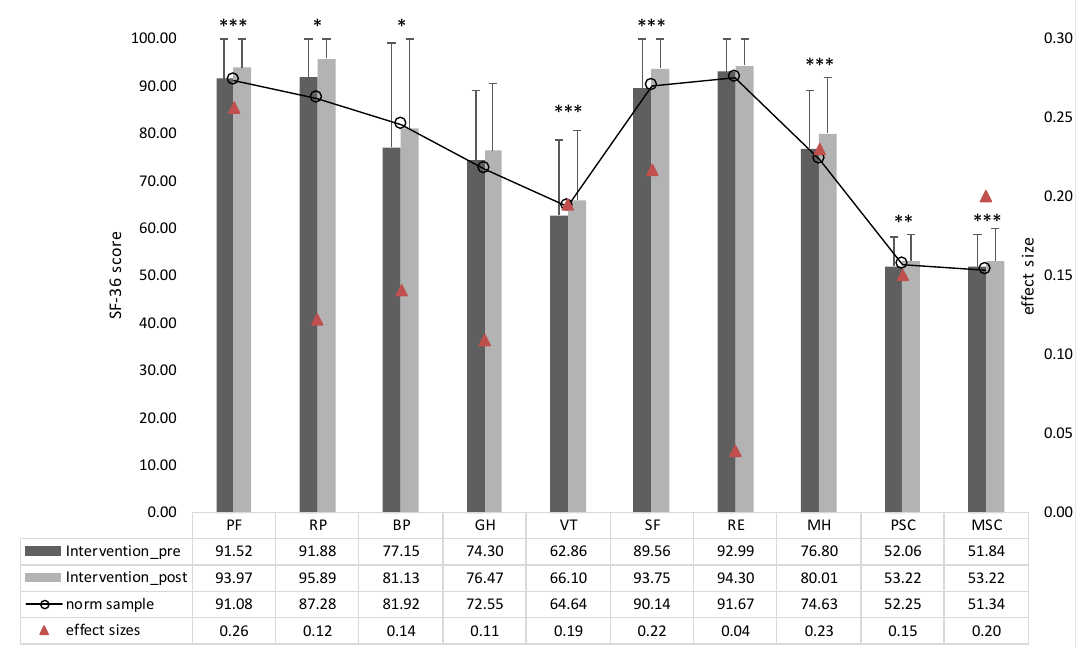
Figure 4. Mean values at baseline and after intervention for SF ‐ 36 outcomes of the intervention group.